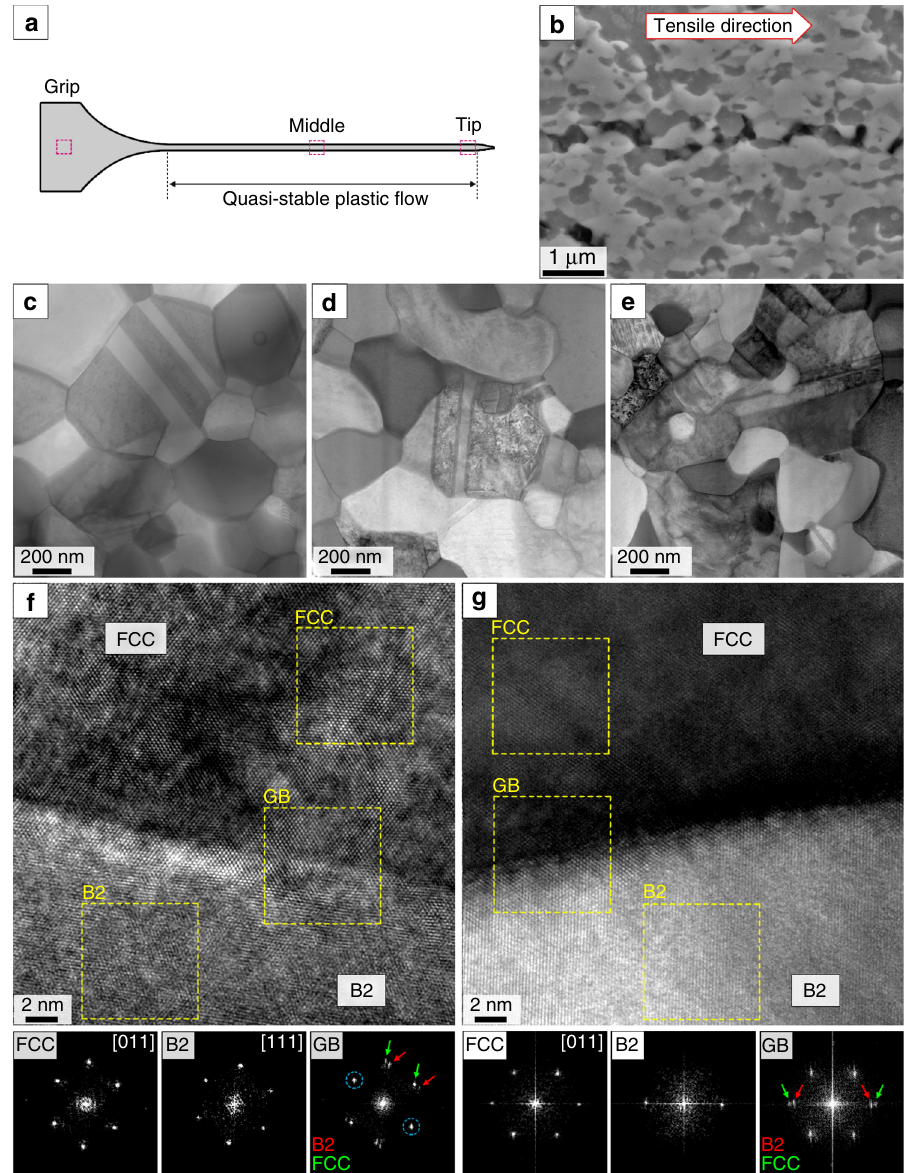
Fig. 3 Microstructural analysis of superplastic tensile specimen tested at 1073 K and 5 × 10 − 2 s − 1 . a Schematic illustration of superplasticity specimen with denoted positions for analysis, b BSE images of cavity strings from tip of the specimen, c – e Scanning Transmission Electron Microscopy (STEM) images from grip, middle and tip, ( f , g ) High Resolution (HR)- TEM images from grip and tip with corresponding Fast Fourier Transform (FFT)- Selected Area Electron Diffraction (SAED) patterns. “ GB ” in f , g stands for Grain